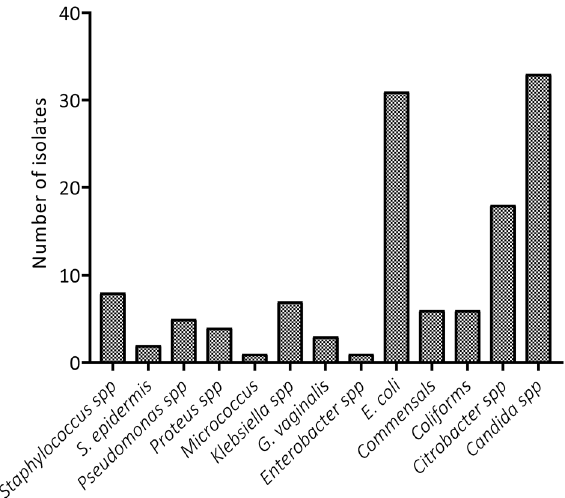
Figure 1. Type and frequency of microorganisms isolated from the patient visiting the health facility.